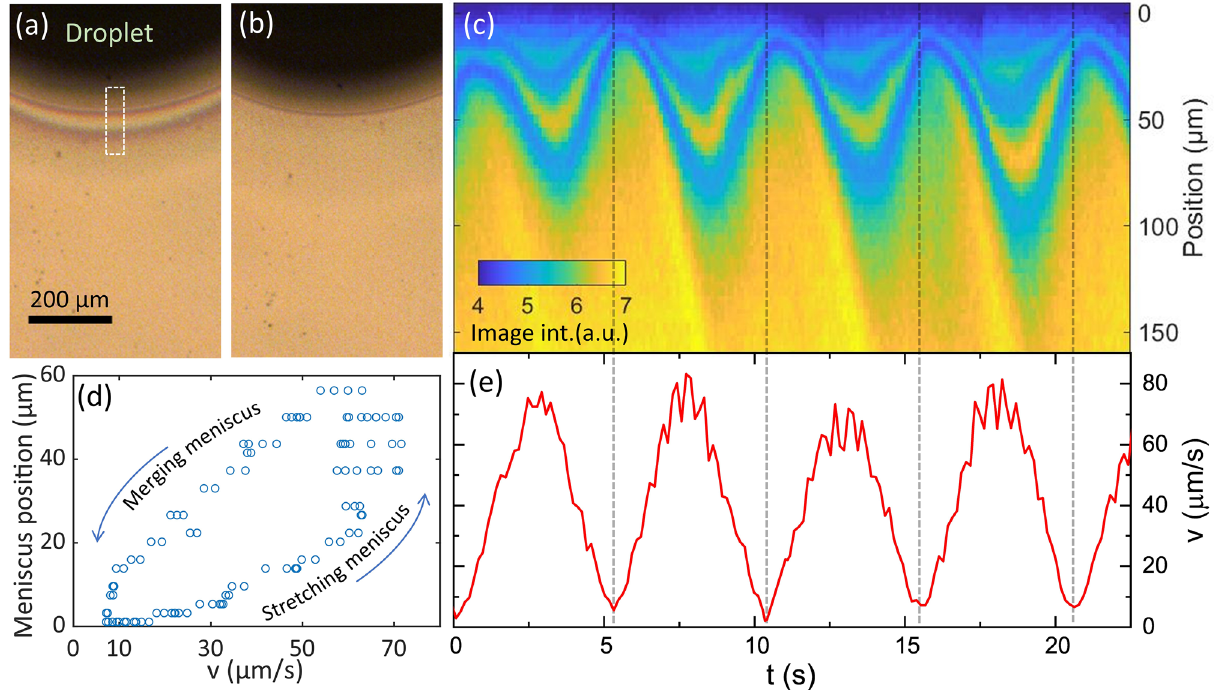
Figure 4. Transient meniscus shape and spatially modulated deposition ( a , b ) Optical micrograph of the precursor droplet (viewed from above) during different phases of the substrate movement (panel ( a ): t = 8.85 s and v = 48.6 µm/s; panel ( b ): t = 10.95 s and v = 19.5 µm/s). Interference fringes close to the droplet boundary indicated the thin region of the stretch liquid meniscus. ( c ) Intensity line profiles of the optical micrographs close to the meniscus recorded at different times. Temporal changes in the interference pattern of the meniscus and the local thin-film deposition density are visible. Line profiles correspond to the white-boxed area in panel ( a ) and are averaged along the horizontal direction. ( d ) Extracting from panel ( c ) the extend of the meniscus for different transient substrate speeds reveals that during speed cycling the meniscus does not adopt a steady-state geometry. ( e ) Extracted substrate velocity derived from the movement of local surface features. Slight differences with respect to the set-velocities (v set = 67 µm/s) might be related to the inertia of the stage as well as small inaccuracies in the video frame